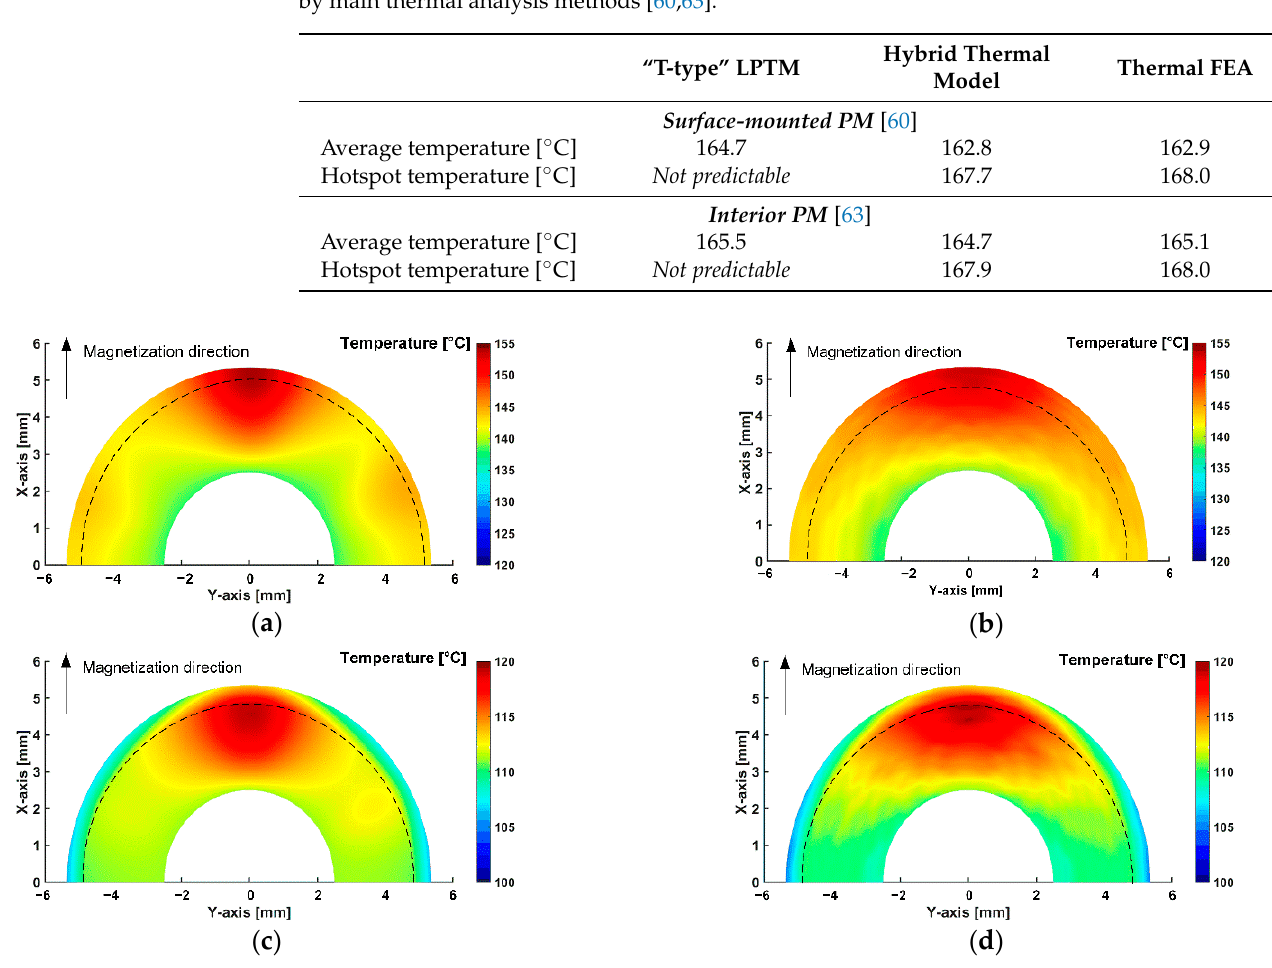
Table 6. Comparison of steady-state average and hotspot temperatures of SPM and IPMs predicted